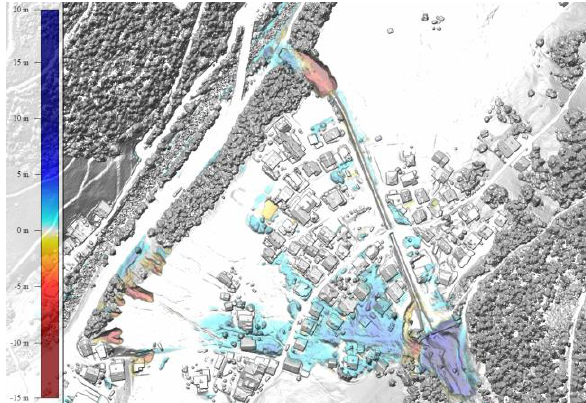
Figure 9. Surface changes visualized on the image-based